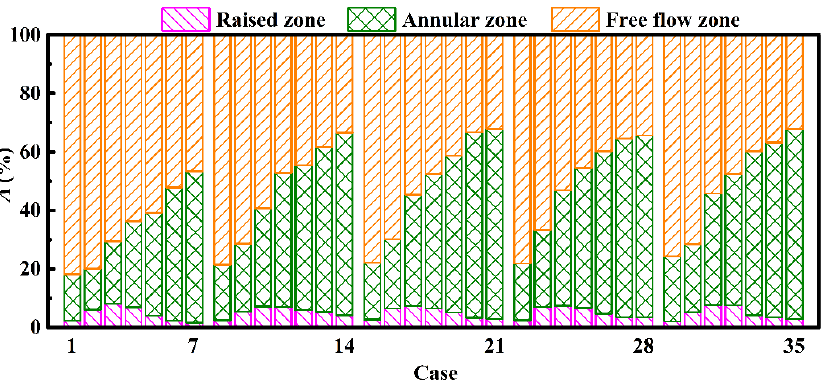
Figure 8. Variations of film coverage rates of different divided